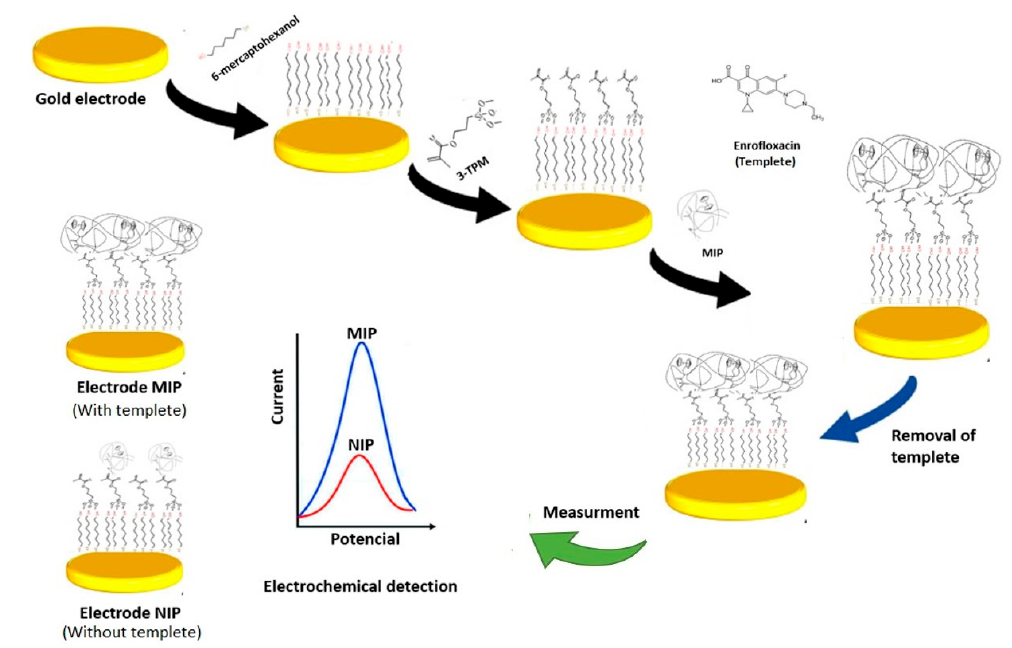
Scheme 1. Graphical representation of an electrochemical